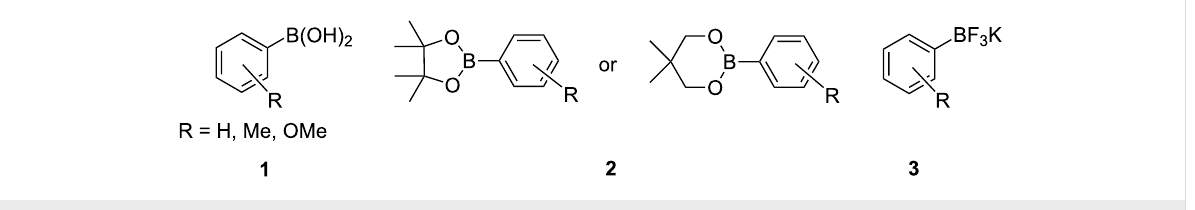
Figure 1: Structures of organoboron compounds 1–3 .